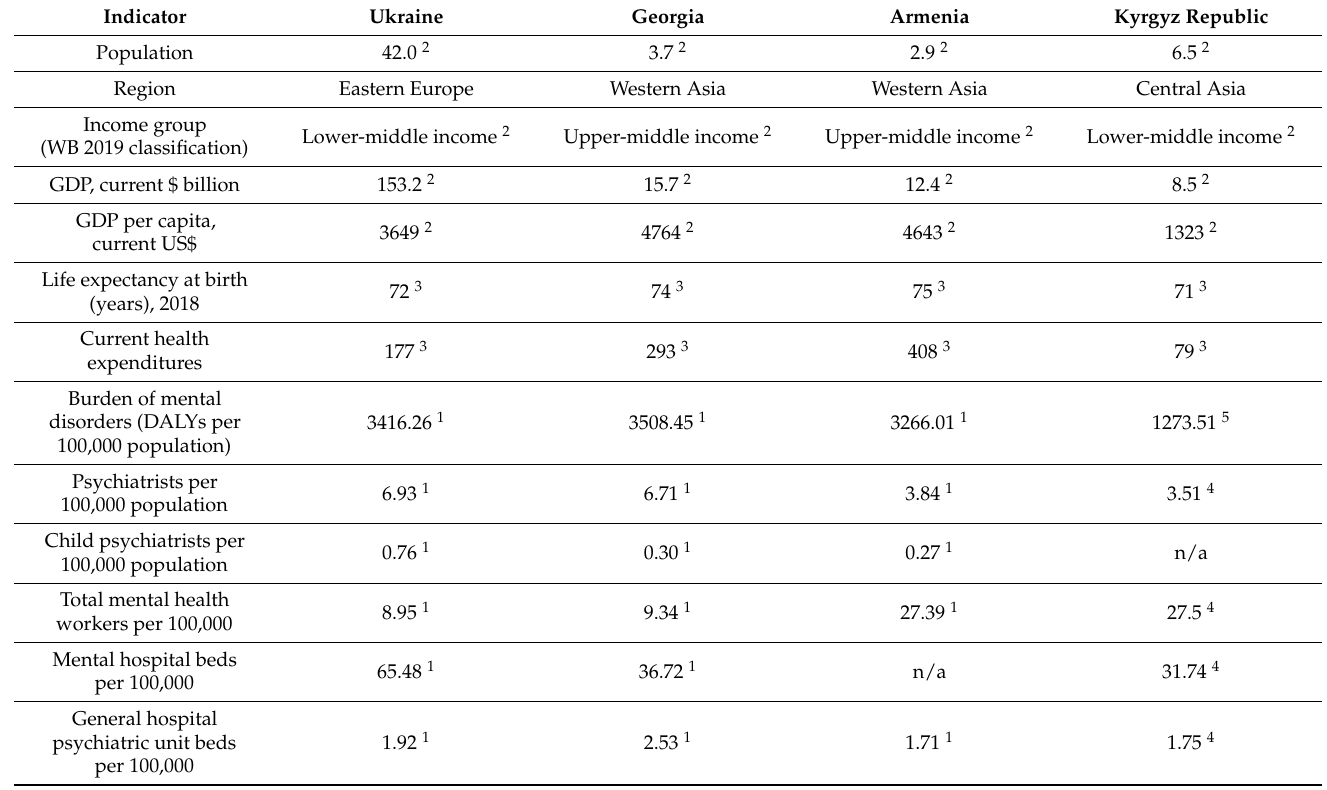
Table 1. Ukraine, Georgia, Armenia, and Kyrgyz Republic: countries context.